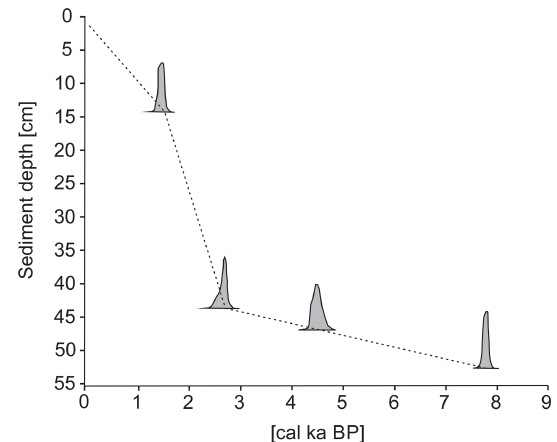
Figure 3. Age–depth model of the ST_1.5 core. The grey silhou- ettes show the probability distribution of calendar dates that were obtained by calibration of the individual 14 C dates used for the age model. The dotted line shows the age–depth model derived from a linear interpolation between the